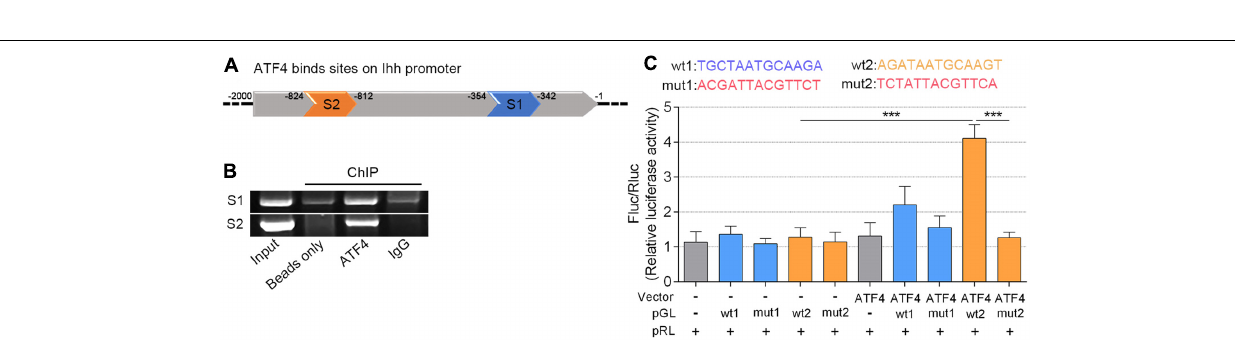
Frontiers in Cell and Developmental Biology |